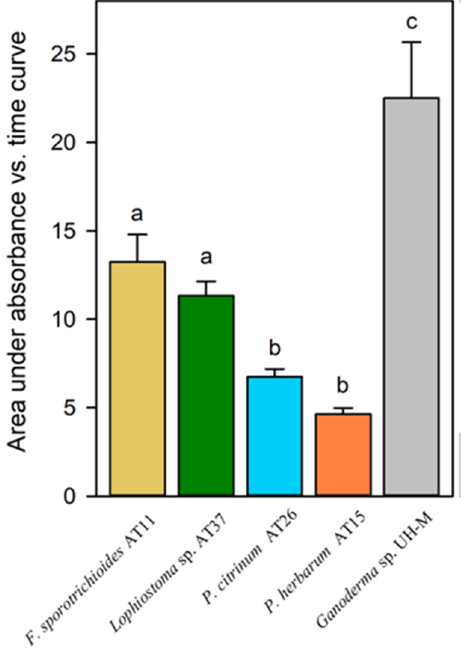
Figure 4. Fungal hydroxyl radical production presented as the area under the absorbance (311 nm) versus time curve. Production of hydroxyl radicals by the epiphytic fungi isolated from Bóbrka and Warsaw together with the positive control for laccase and peroxidase production Ganoderma sp. UH-M was measured for five days. Statistically significant differences in hydroxyl radical production between the different strains are indicated with letters above each column; columns with a different letter are significantly different ( p < 0.05) according by ANOVA followed by post hoc test.